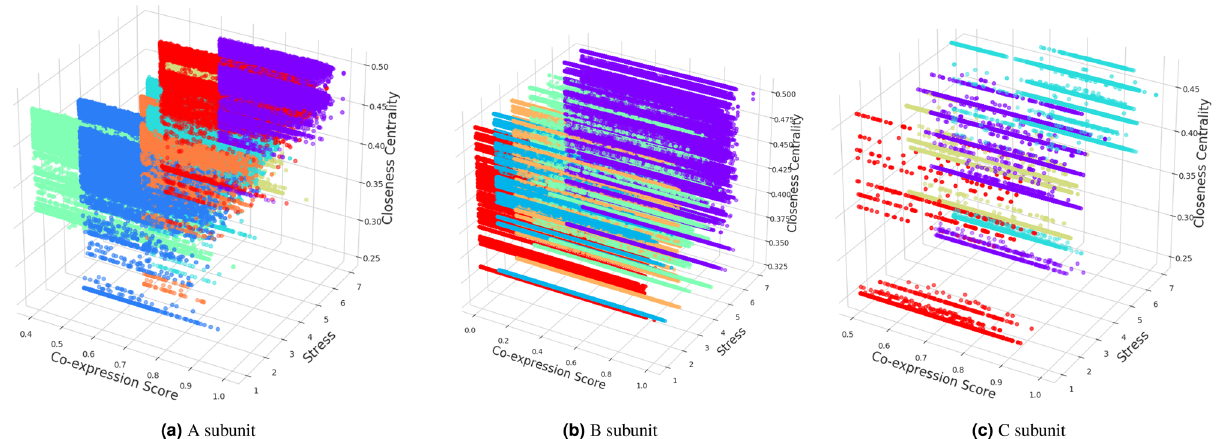
Figure 8. 3D Scatter plot illustrating the clustering results. Three dimensions are co-expression value, stress condition, and closeness centrality. Colours represent different clusters. Genes in A, B, and C subunits are grouped into 7, 5, and 4 clusters,